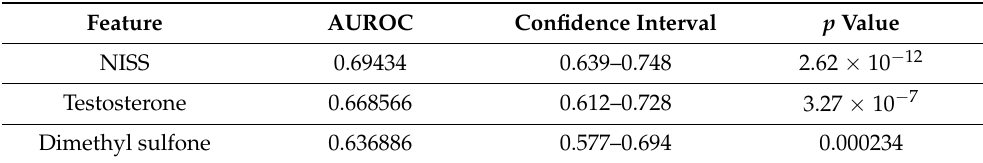
Figure 3. Metabolomic profiling improves the accuracy of clinical variables for discriminating between trauma patients with a short or prolonged ICU LOS. Receiver operator characteristic curves for models built on: ( A ) the combined variables of NISS and testosterone, or ( B ) NISS and all 9 serum metabolites (dimethyl sulfone, cadaverine, isoleucine, acetoacetate, urea, syringate, acetone, xylitol and creatinine) detected in the acute post-injury phase that were selected from our PLS-DA model for discriminating between patients with an ICU LOS < 10 or ≥ 10 days. Table 2. Area under the receiver operating characteristic curve (AUROC) values, confidence intervals (C.I) and p values for the metabolites and clinical variables selected from our PLS-DA model based on a VIP >